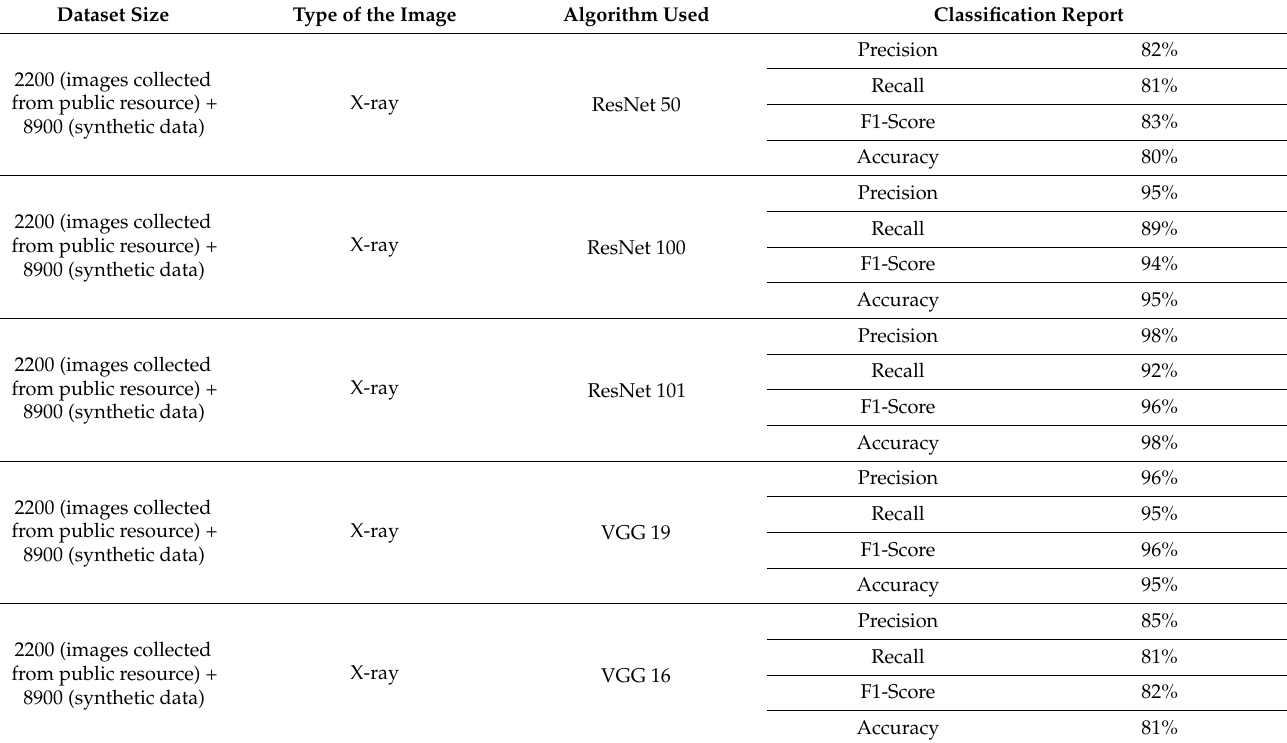
Table 4. Performance analysis of deep convolution neural network architectures on X-ray